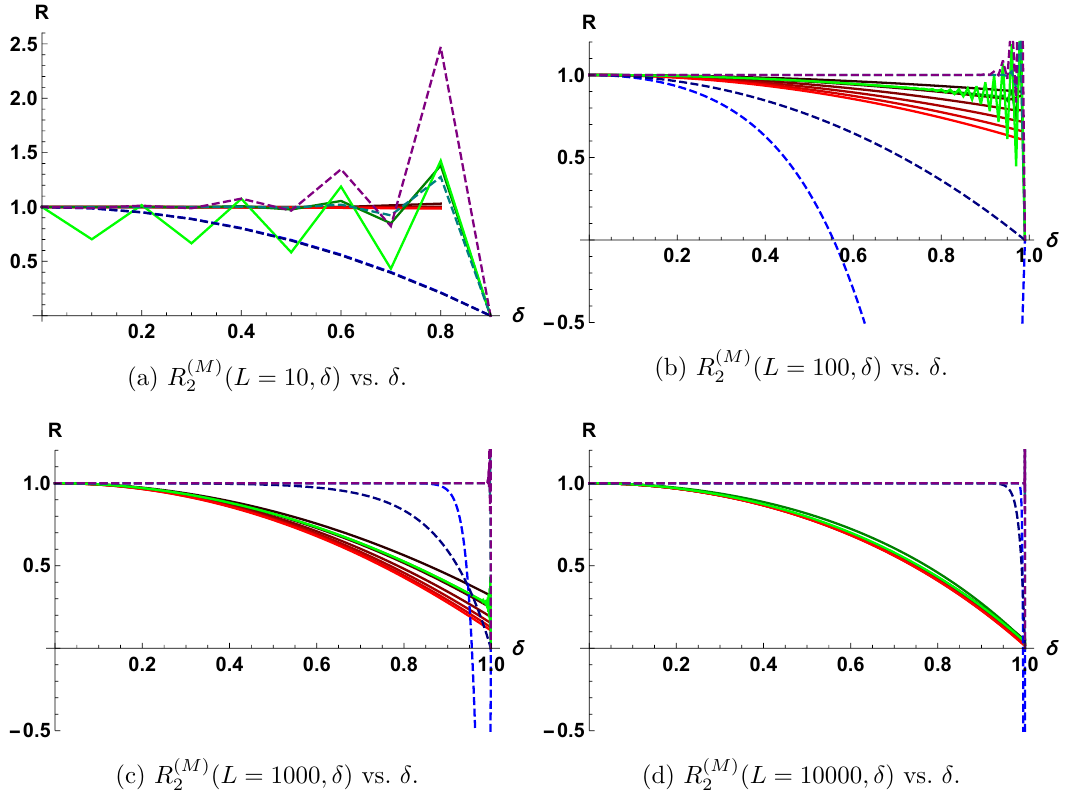
Figure 7. Mass multipole ratios without M 0 in the numerator: R ( M ) figure